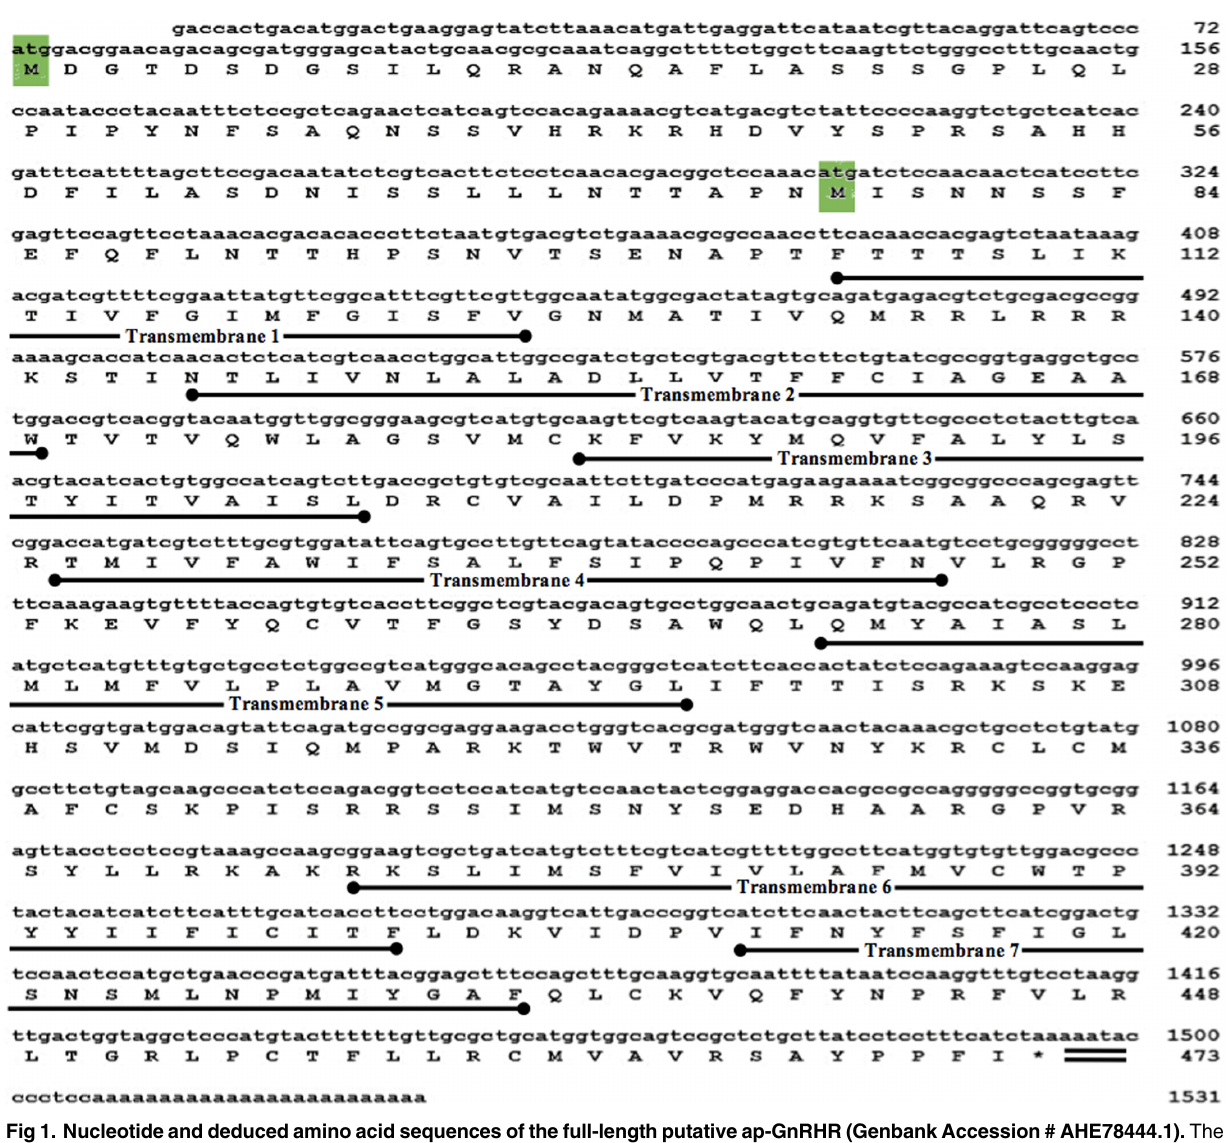
Fig 1. Nucleotide and deduced amino acid sequences of the full-length putative ap-GnRHR (Genbank Accession # AHE78444.1). The nucleotides (lower case letters) and amino acids (upper case letters) are numbered accordingly. The seven predicted transmembrane domains are underlined. The two putative translation start sites are highlighted in green, and the asterisk ( * ) denotes the stop codon. The nucleotides corresponding to the truncated polyadenylation signal (aata) are double-underlined.